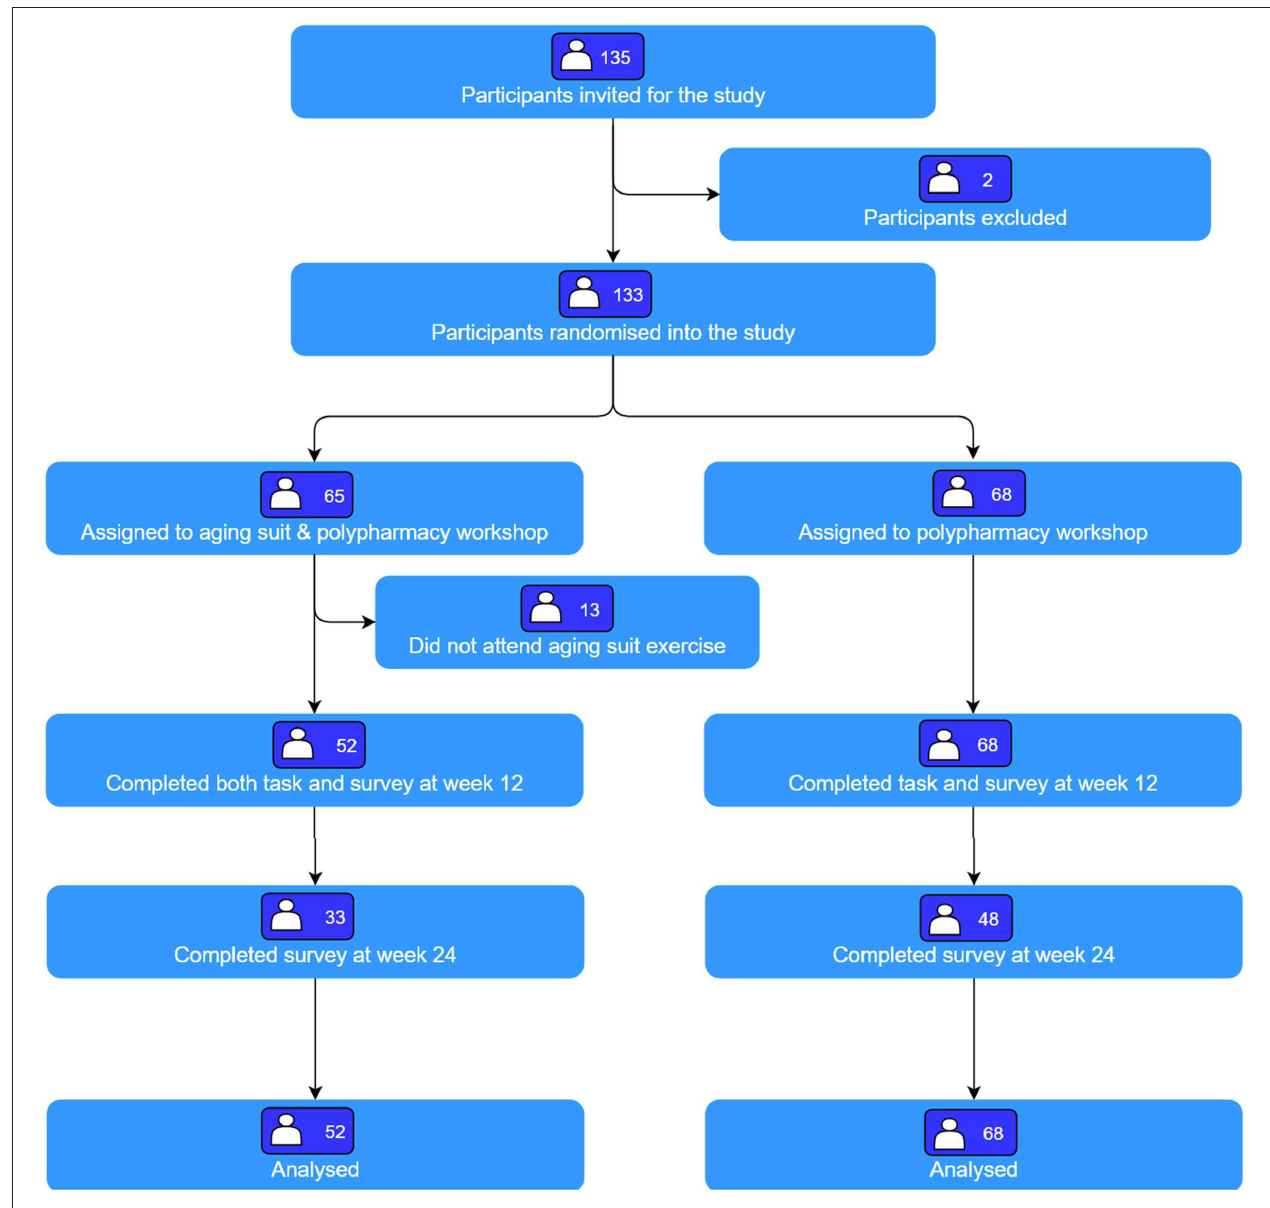
FIGURE 3 | Participant flow through the